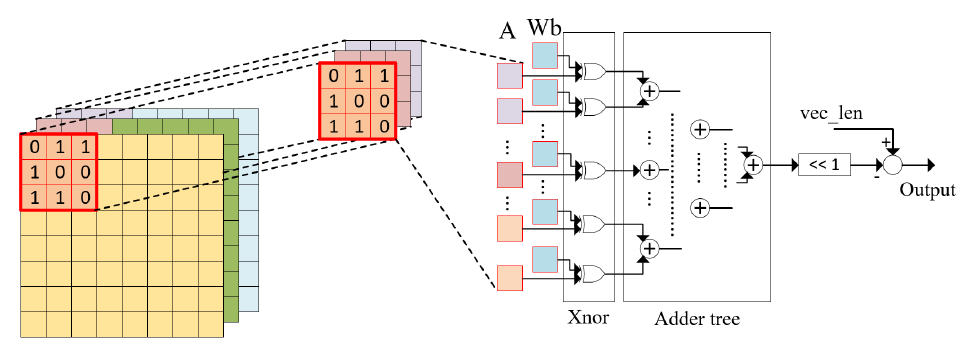
Figure 1. Xnor operation and accumulation on a convolution